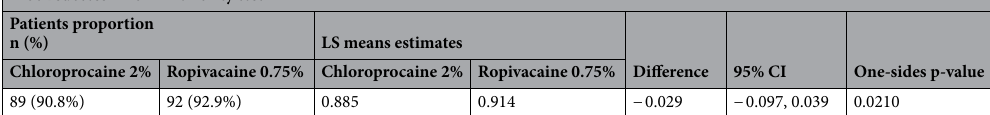
Table 3. Block success. The lower limit of the 95% two-sided confidence interval of the difference between the two treatments proportion of success was above the pre-established 10% non-inferiority margin (δ = − 0.1) with clinical